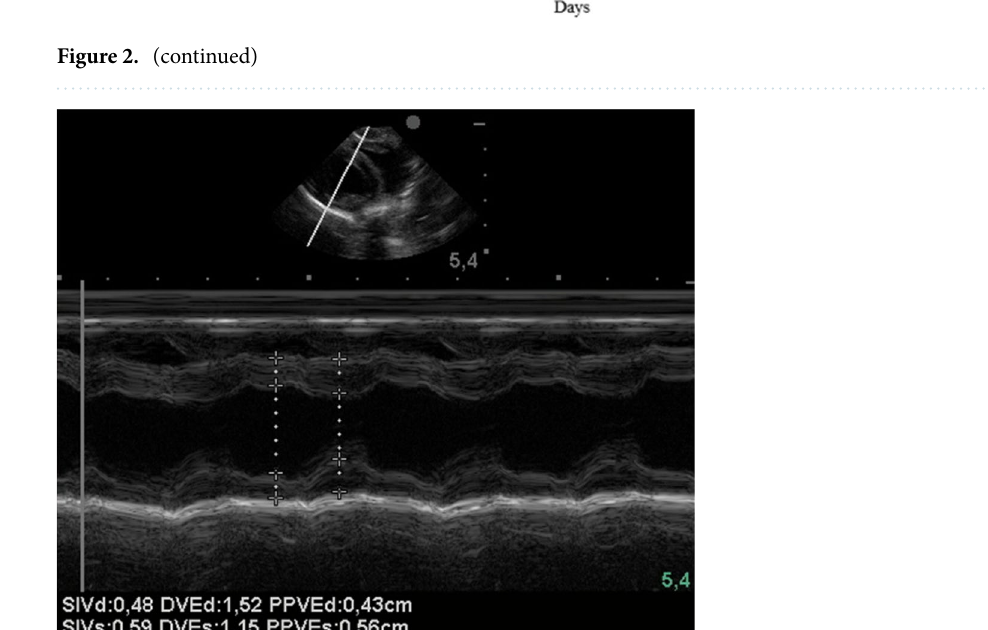
Figure 3. Echocardiographic evaluation, M-mode, left ventricular diameter end-diastolic and